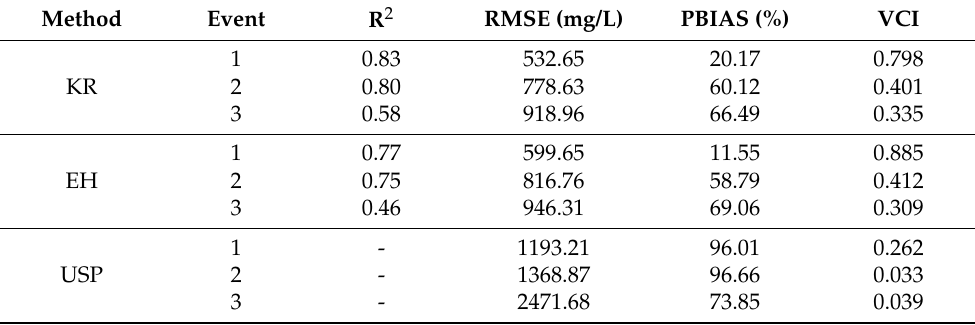
Figure 4. Flow discharge predicted by the GSSHA model in Event 1 ( a ), Event 2 ( b ), and Event 3 ( c ). The scatter plots (and R 2 values) represent a 1:1 comparison between the prediction (y-axis) and the observation (x-axis), and the black lines denote the stream discharge. Table 6. Statistical analysis of observed and predicted values of sediment